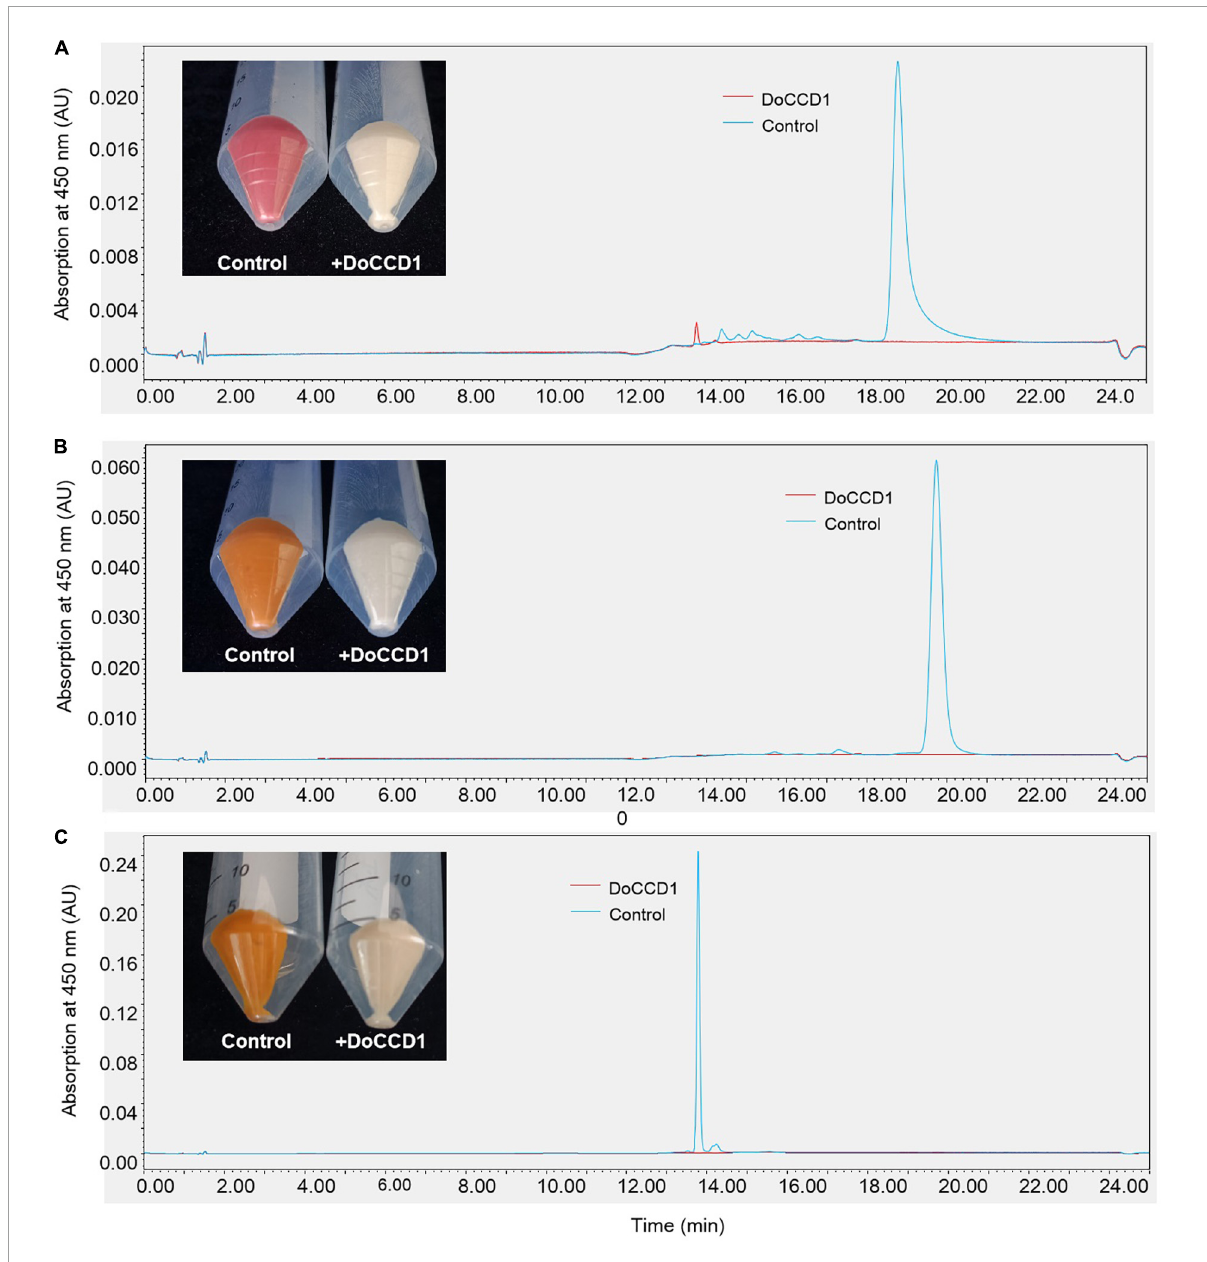
FIGURE5 The color changes and HPLC analysis of E. coli strains. (A) E. coli strain can accumulate lycopene (pACCRT-EIB). (B) E. coli strain can accumulate beta-carotene (pACCAR16 (cid:77) crt). (C) E. coli strain can accumulate zeaxanthin (pACCAR25 (cid:77) crtX). Control stands for the strain containing empty vector pThio-Dan1 while + DoCCD1 stands for the strain containing plasmid